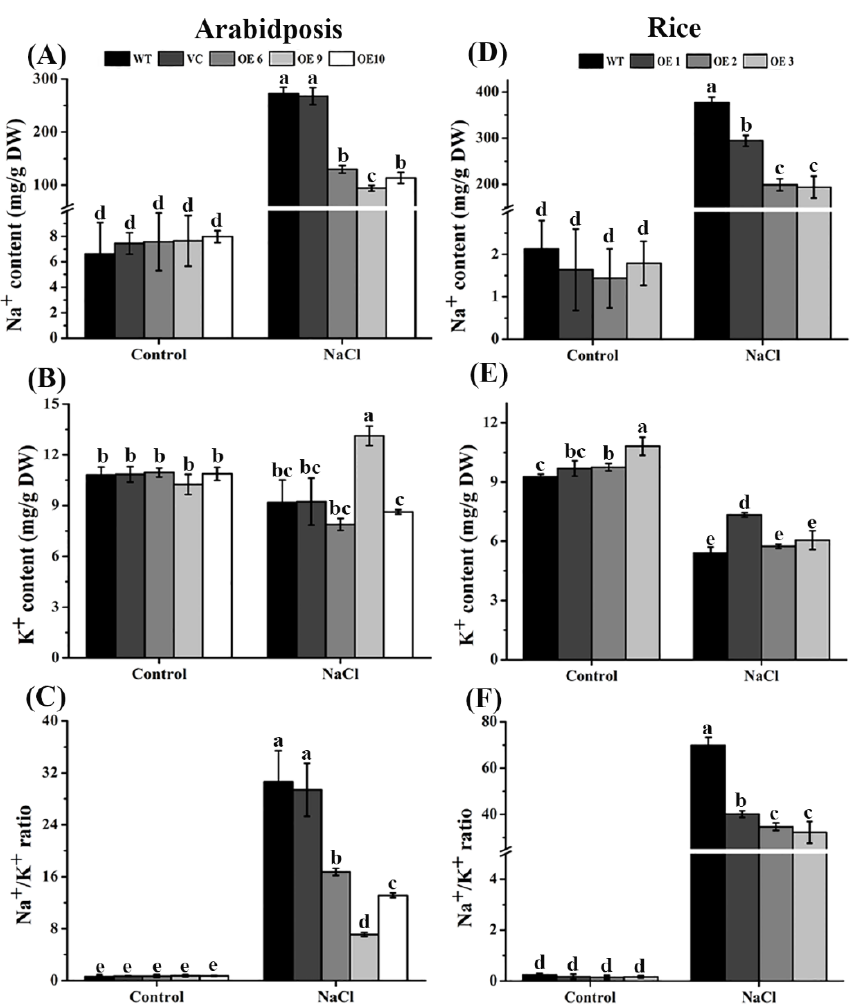
Figure 7. Effects of salt on the accumulation of Na + and K + in WT and transgenic plants of Arabidopsis and rice. WT and various OE plants were exposed to NaCl for 2 weeks, and leaves of the plants were collected for measuring the contents of Na + and K + . ( A – C ) were Na + contents, K + contents and Na + /K + values in Arabidopsis , respectively; and ( D – F ) were Na + contents, K + contents and Na + /K + values in rice, respectively. Values are mean ± SD (n ≥ 3). Different lowercase letters above the error bars indicate that the data of various plants significantly differed from each other by one way ANOVA and Tukey’s HSD test ( p < 0.05).